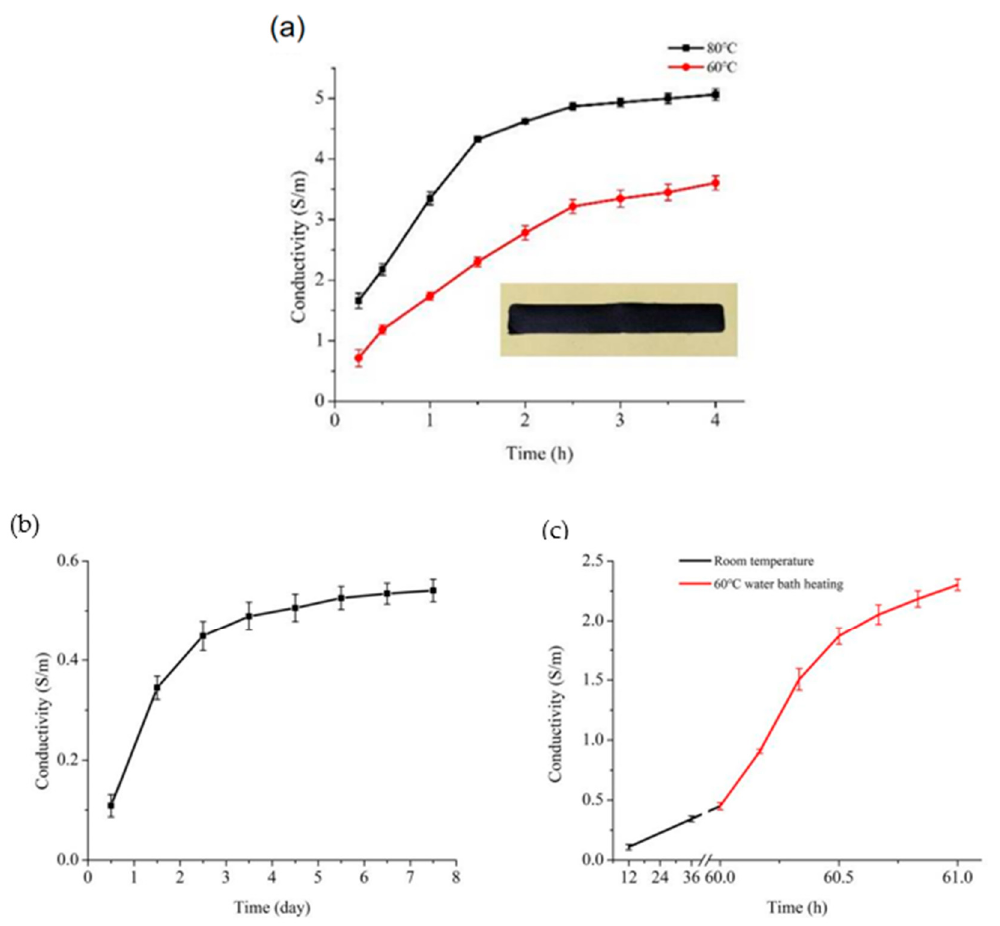
Figure 6. The conductivity of the CNT/SMP composite inks as functions of time ( a ) at 80 ◦ C, 60 ◦ C, ( b ) room temperature (25 ◦ C), and ( c ) stepwise curing conditions.